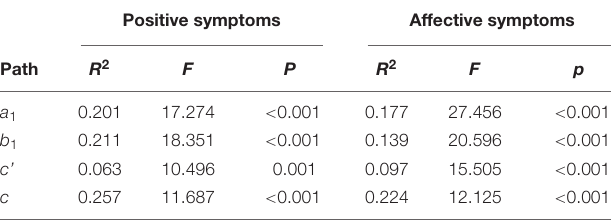
TABLE 2 | Standardized coefficients of hierarchical regressions predicting PANSS scores.